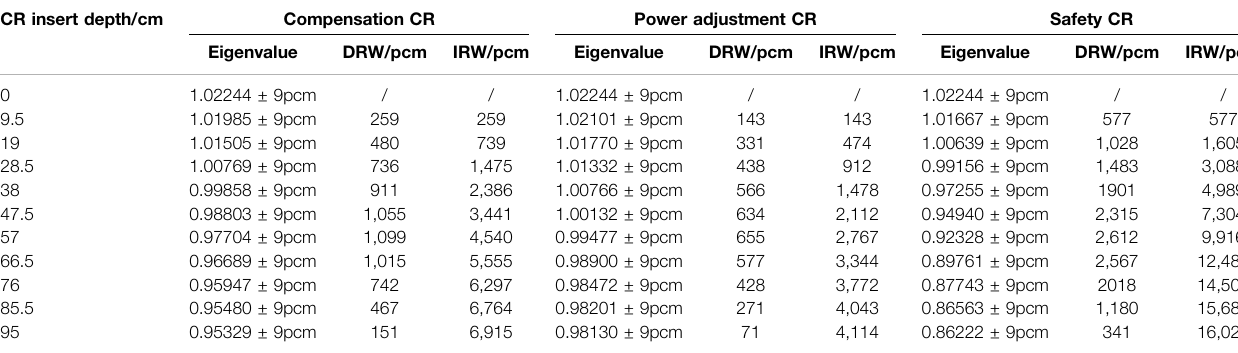
TABLE 2 | Control rod worth of the SLBR-50.